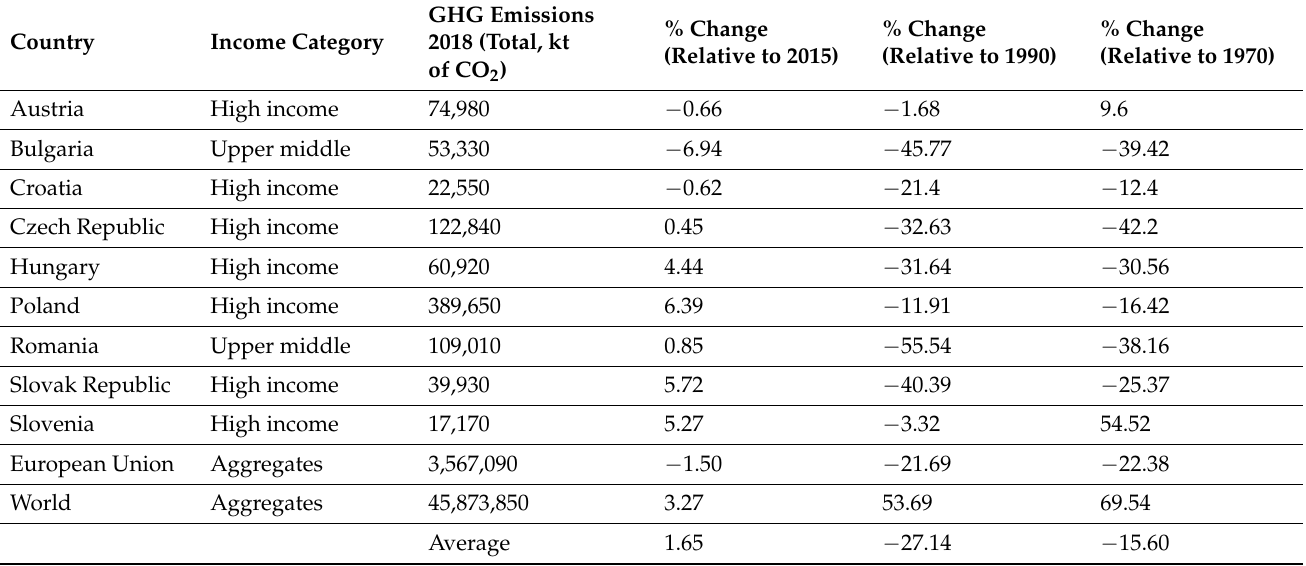
Table 1. Greenhouse gas emissions in nine EE countries: 2018 data and historical